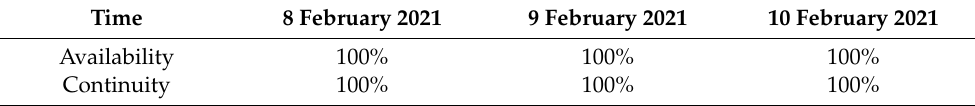
Table 4. The availability and continuity of two-way timing service (orbit maneuver state).